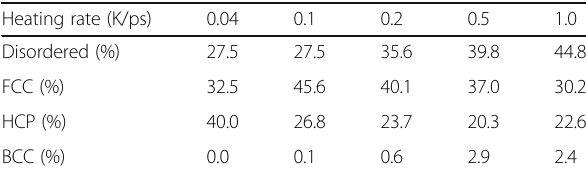
Table 2 Number fraction of atoms with different local crystalline orders in the products sintered under different heating